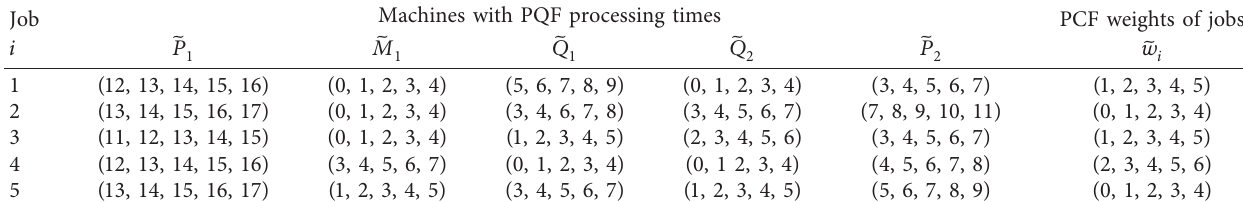
� ( a , a , a ,a ,a ) . ij 1 2 3 4 5